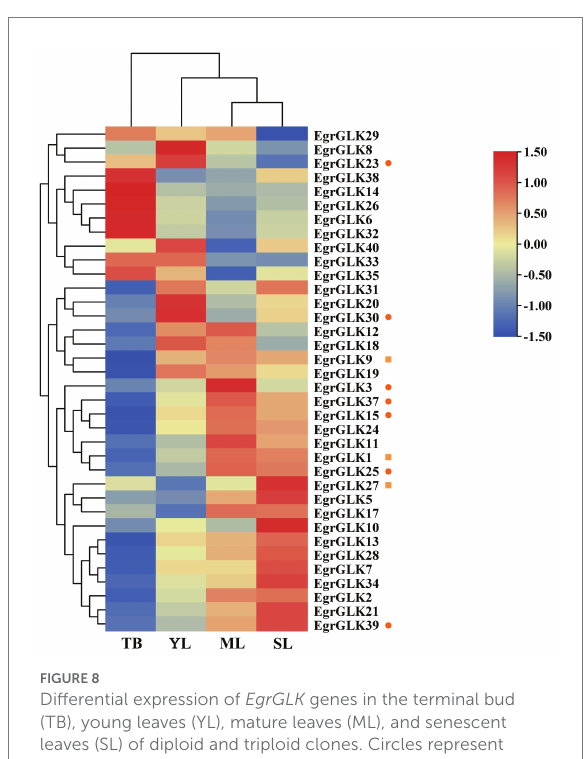
FIGURE 8 Differential expression of EgrGLK genes in the terminal bud (TB), young leaves (YL), mature leaves (ML), and senescent leaves (SL) of diploid and triploid clones. Circles represent highly expressed genes common to the diploid and triploid clones, and squares represent genes highly expressed only in the triploid